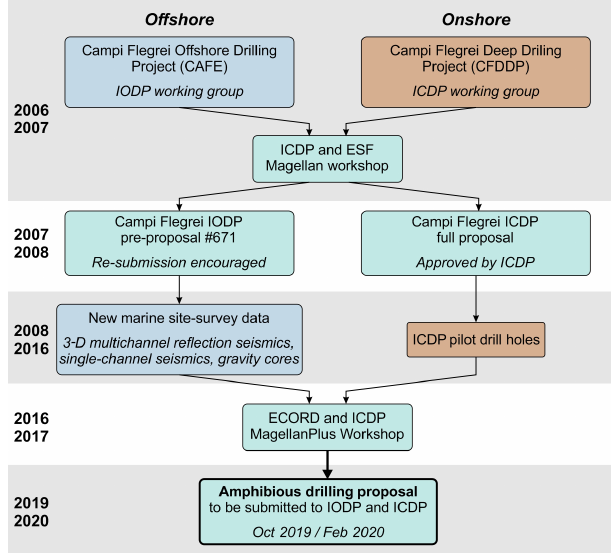
Figure 4. Flow chart illustrating the history of site-surveying ac- tivity and nurturing of the continental (ICDP) and marine (IODP) components of the Campi Flegrei Amphibious Drilling Proposal.